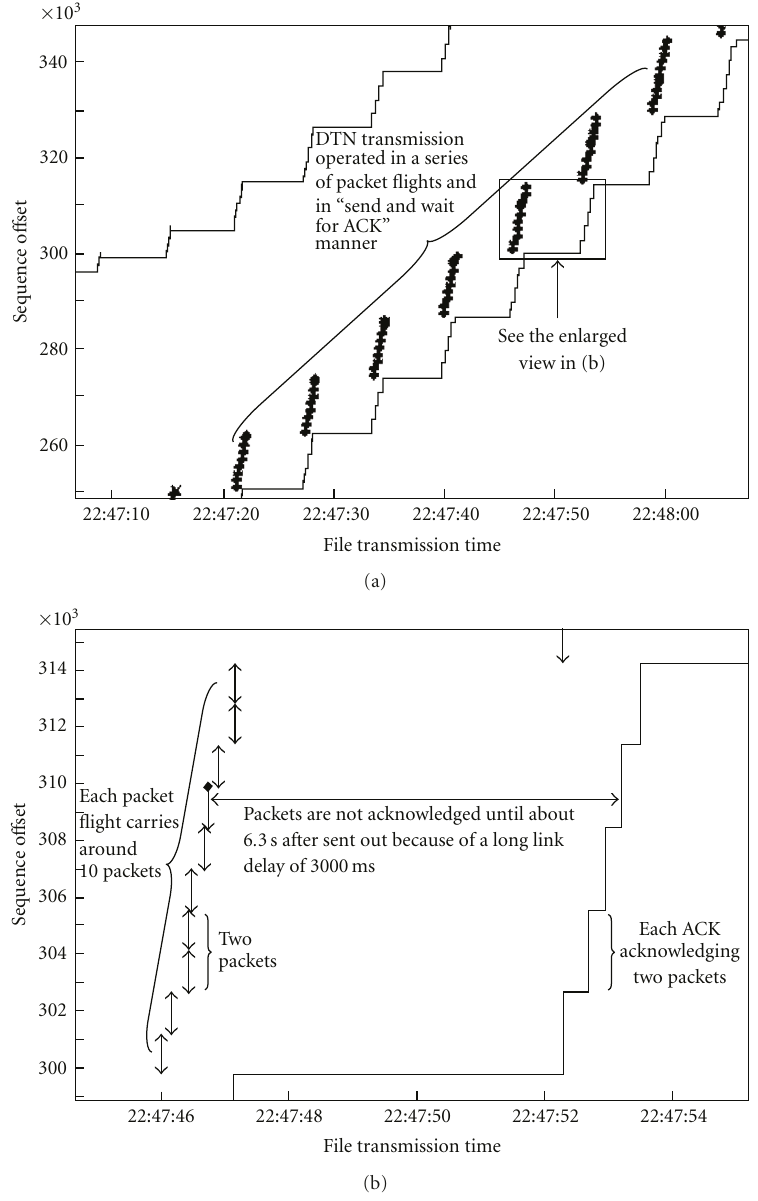
Figure 10: Tra ffi c pattern of DTN transmission from MX to RX over cislunar channels with link delay of 3000 ms and link disruption of 4 hours without error. (a) DTN transmission in a series of packet flights. (b) Enlarged view of the fifth packet